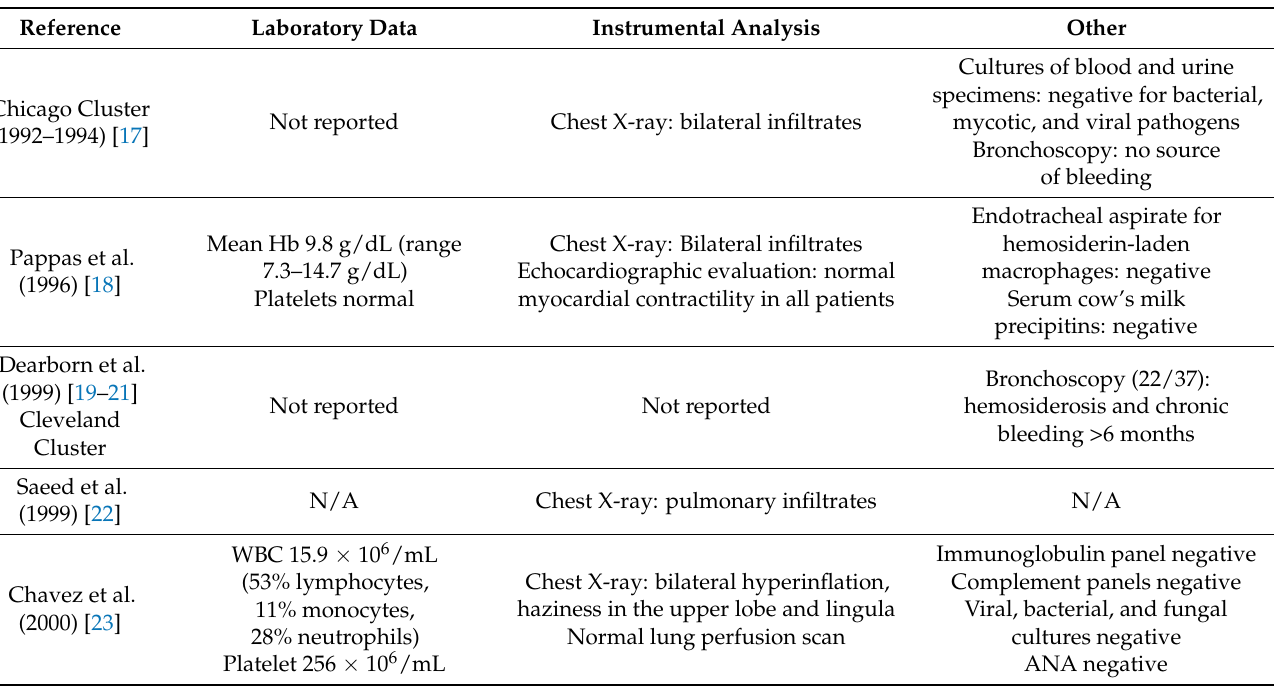
Table 2. Data collection of laboratory and imaging findings of AIHPI from a systematic review of the current literature. (WBC, white blood cell; RBC, red blood cell; Hb, Hemoglobin; ANA, antinuclear